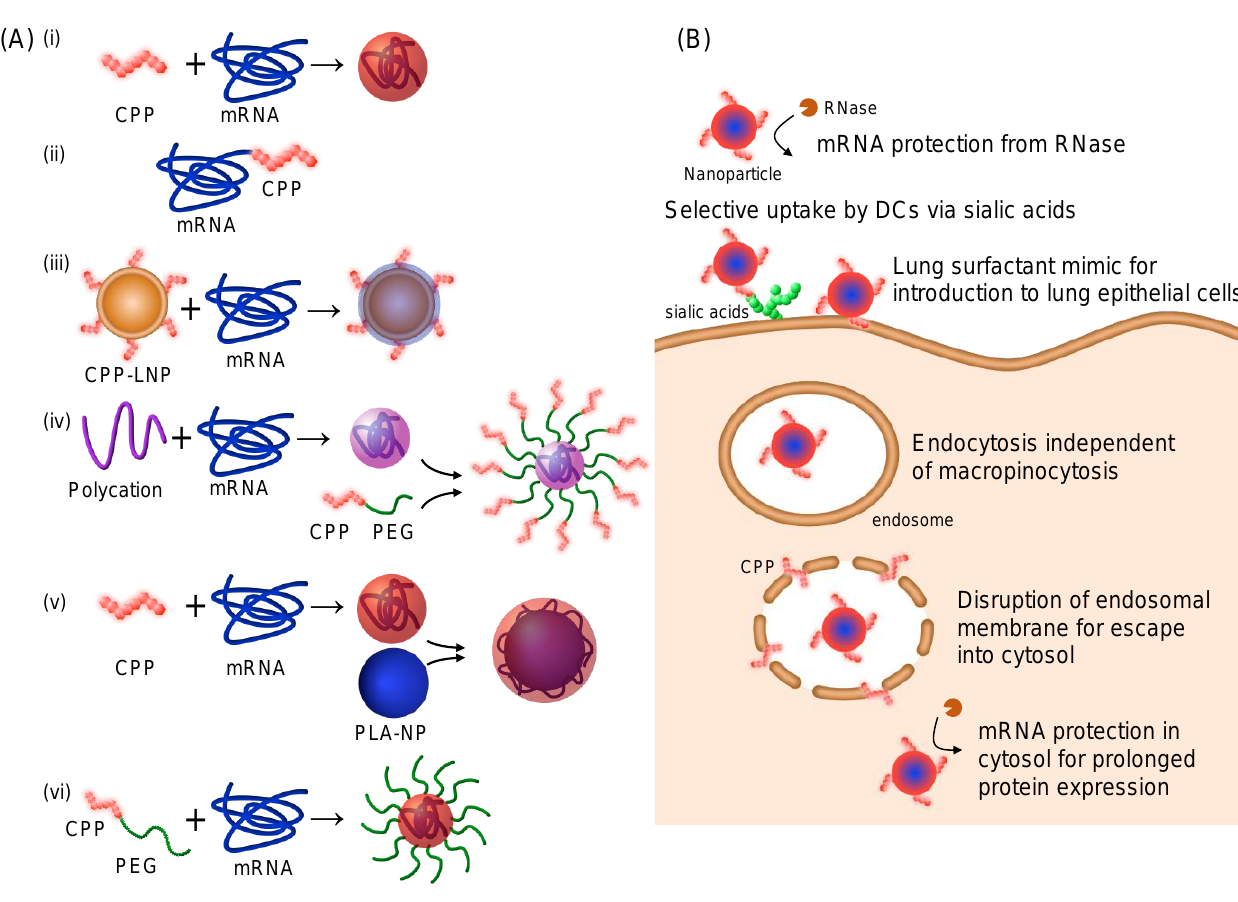
Figure 1. Cell-penetrating peptides (CPPs) for mRNA delivery. ( A ) Preparation of CPP-based mRNA nanoparticles. ( i ) Physical mixing of CPPs and mRNA. ( ii ) Covalent conjugation of CPP to mRNA. ( iii ) Lipoplex preparation from CPP-introduced lipid nanoparticle (LNP) and mRNA. ( iv ) Post-conjugation of poly(ethylene glycol) (PEG)-CPP to mRNA and polycation polyplexes via click reaction for presenting CPPs on the surface. ( v ) Coating of poly(lactic acid) (PLA) nanoparticles with CPP/mRNA complexes. ( vi ) Physical mixing of PEG-CPPs and mRNA for preparation of PEGylated nanoparticles. ( B ) Functionalities of CPPs in mRNA delivery.